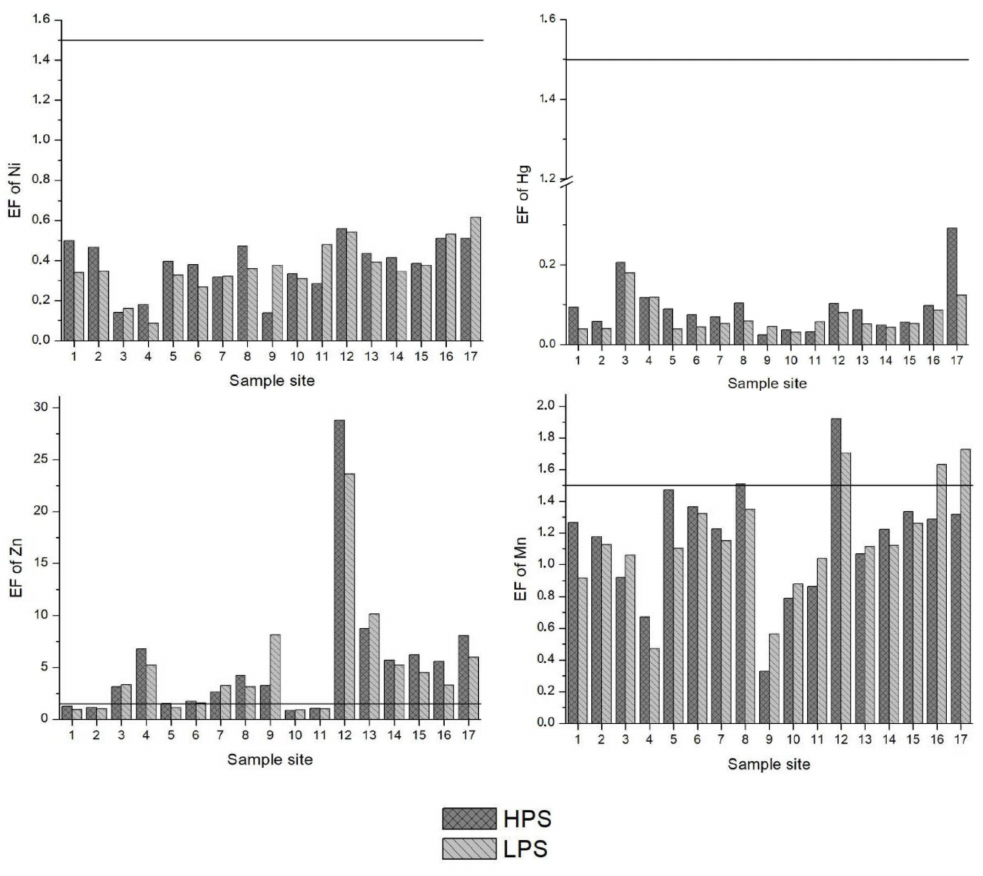
Figure 3. Enrichment Factors (EF) of heavy metals in sediments of samples sites. A value of 1.5 (line) was set as the threshold determining if enrichment levels signified anthropogenic influence.